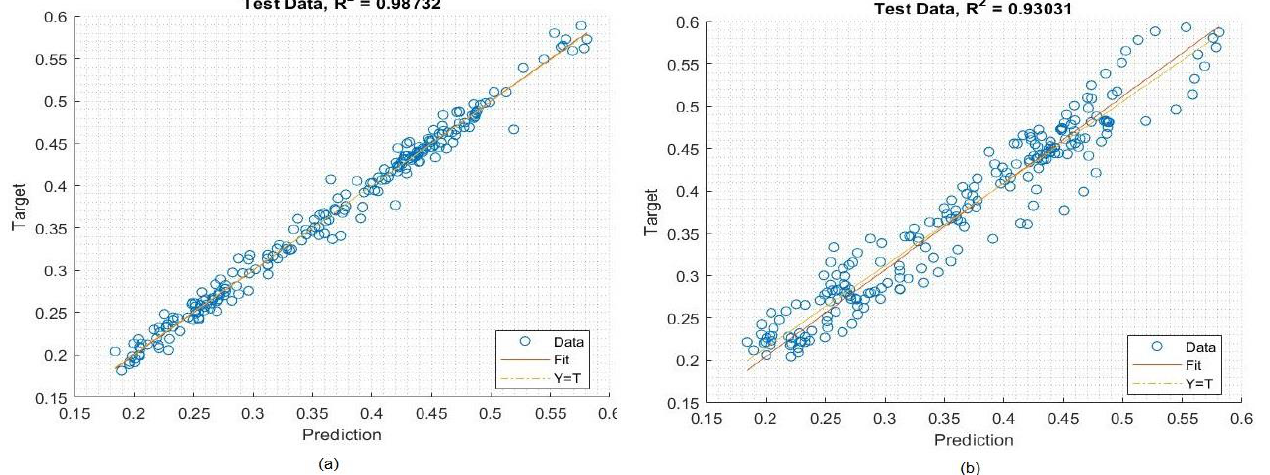
Figure 17. Squared regression plot of the deep learning models ( a ) CNN-LSTM and ( b ) LSTM during the testing phase for Tesla.